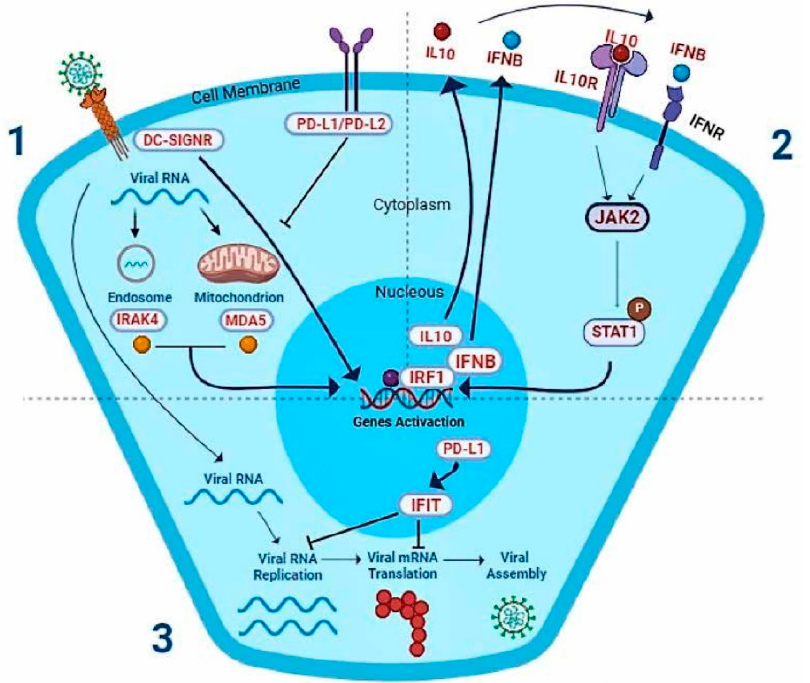
Figure 3. The selected SNPs from the proposed genome polymorphisms/machine severe COVID-19 classifier in cellular context. The genes of the SNPs selected by our classifier are related to IL-10 and IFN cellular pathways, which are highlighted in the figure (in red). In the viral recognition phase (1), the virus is recognized by receptors, such as DC-SIGNR, and then enters the cell, where the vRNA is identified by the intracellular molecules, such as IRAK4 and MDA5 proteins. Then, in the antiviral signaling phase (2), they activate the expression of genes involved in the antiviral response, such as IL-10 and IFN. On the other hand, PD-L1 and PD-L2 are inhibitors of the IL-10 pathway triggered by DC-SIGNR activation. The IL-10 and IFN proteins are delivered to the extracellular compartment, where they connect to their receptors in the cell plasma membrane, activating the JAK-STAT proteins cascade. It triggers the viral blocking phase (3), promoting the expression of antiviral factors that affect viral replication and translation, such as IFIT, as well as positive regulators, including PD-L1 and IRF1. PD-L1, incidentally, activates the expression of other ISGs, maintaining the cell’s antiviral status. While IRF1 is a transcriptional factor that activates the expression of immune genes, such as IFN, PD-L1 and IFIT.